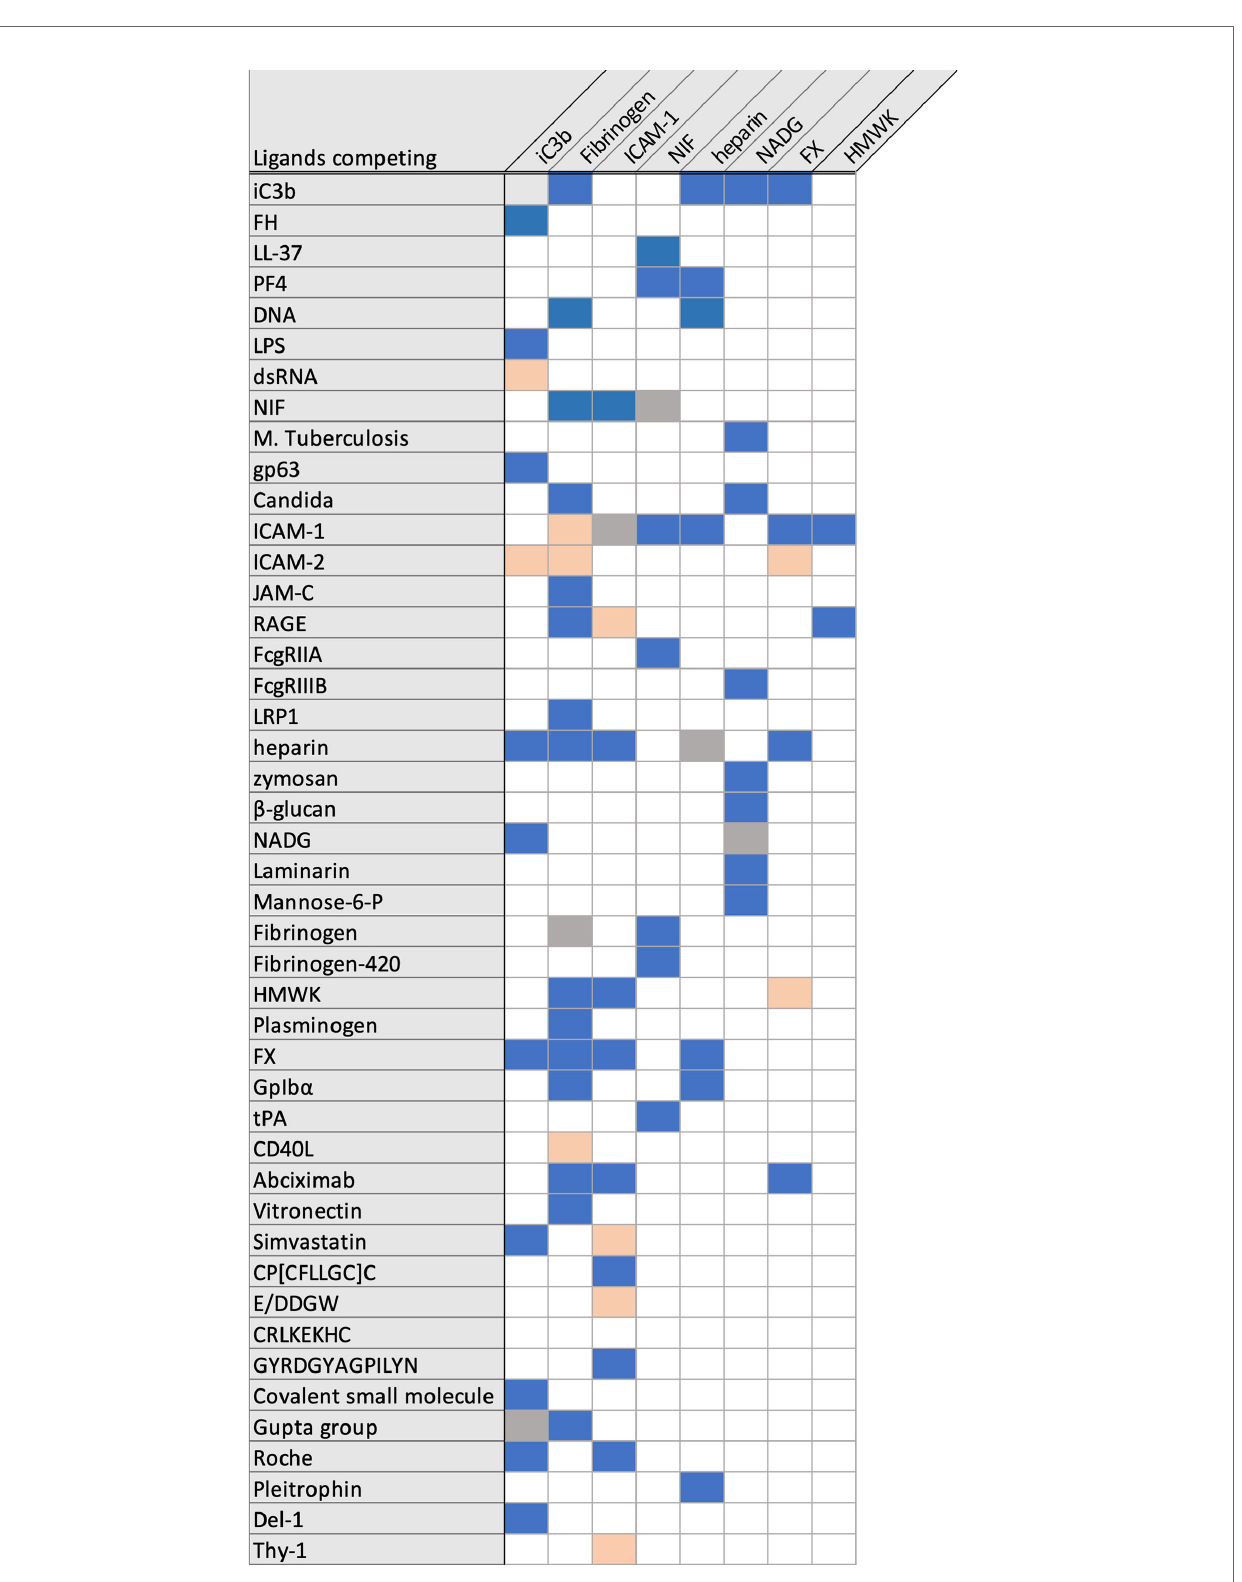
FIGURE 3 | Overview over reported competing/not competing CR3 ligands. Competing ligands are marked in blue, not competing ligands are marked in